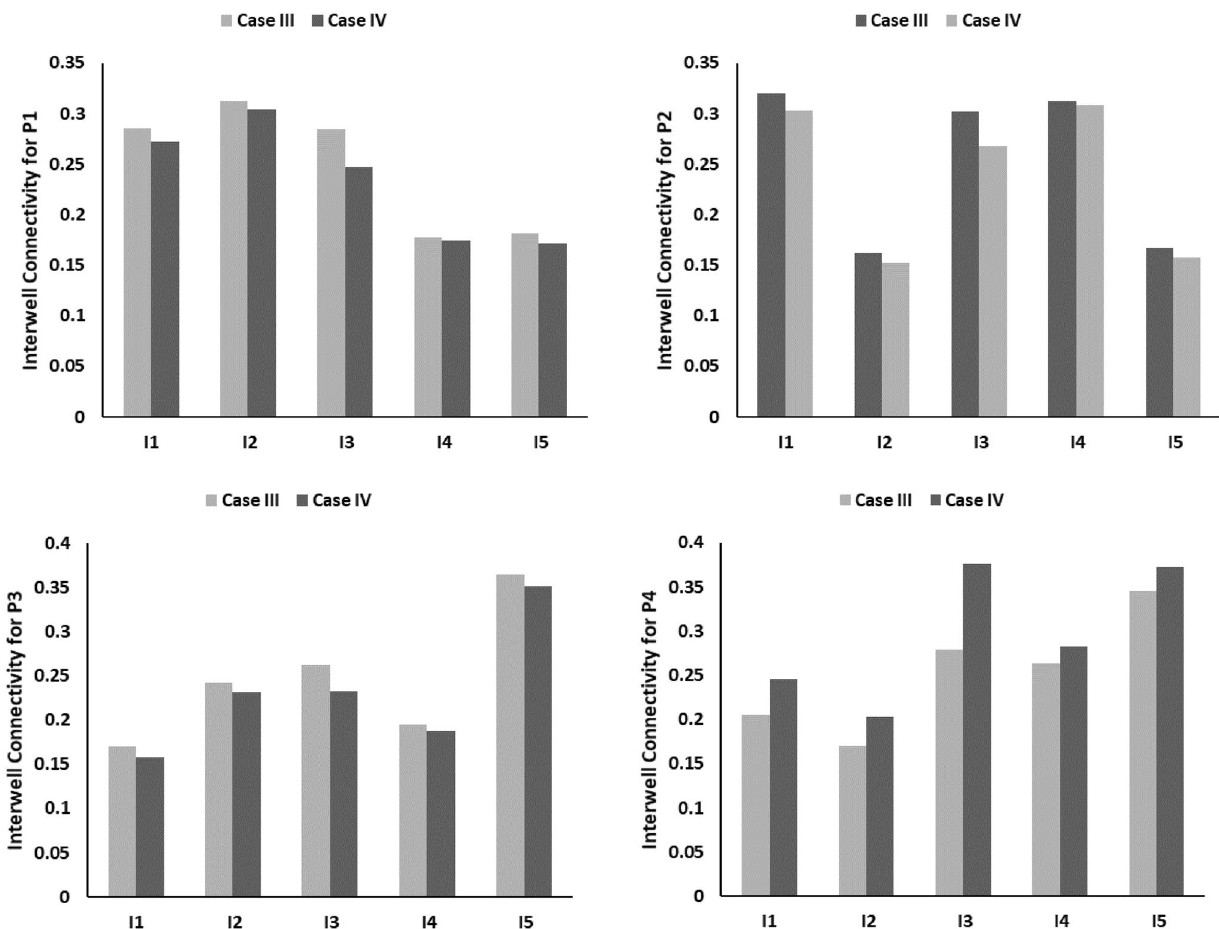
Fig. 20 Comparison between f ij values in case III and case IV